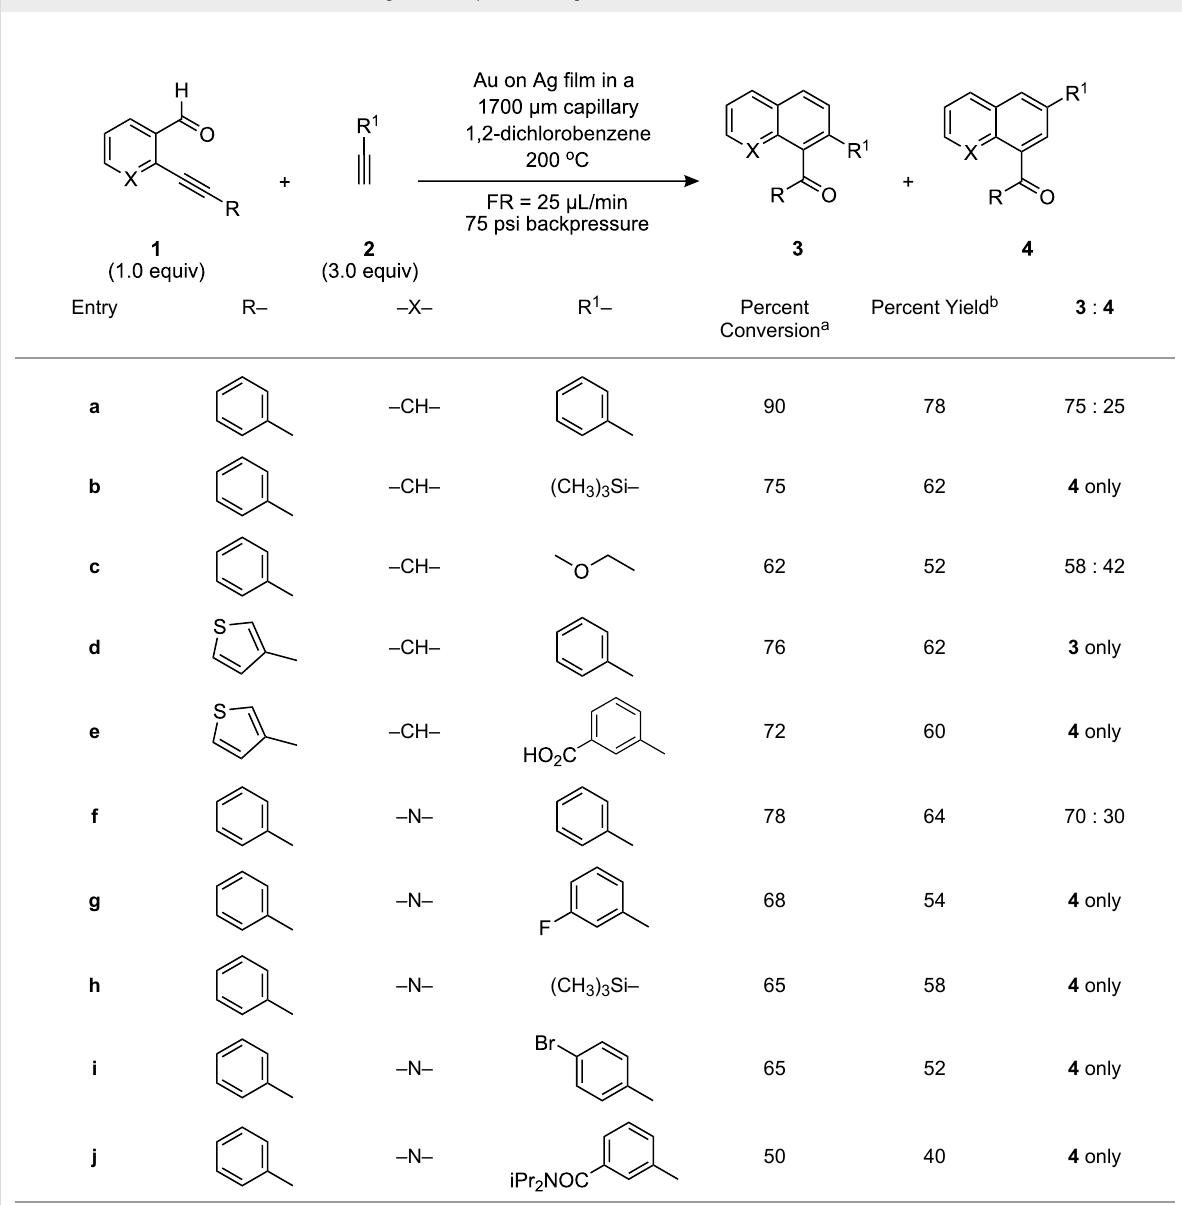
Table 2: Benzannulation reactions with Au on Ag-coated capillaries using